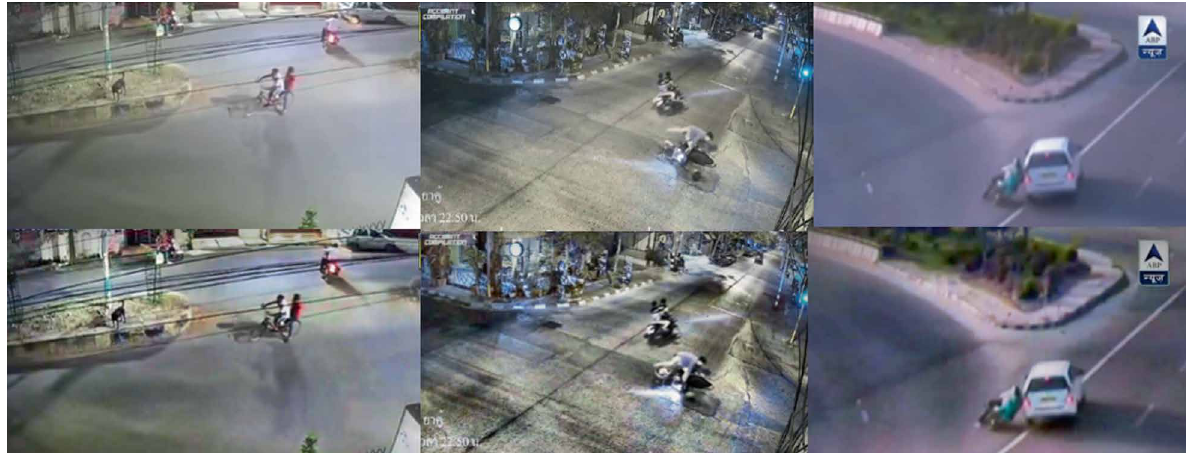
Figure 5: Images before and after